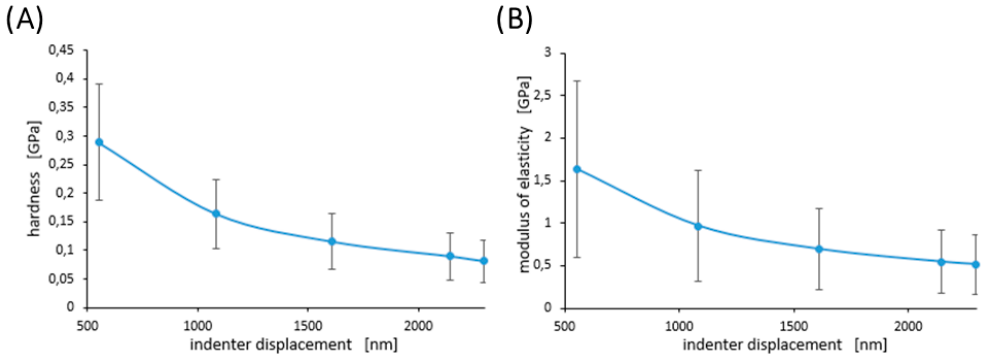
Figure 7. Profiles of hardness (H)—( A ), and modulus of elasticity (E)—( B ) for diamond nanosheet. Error bars represent ± standard deviation.